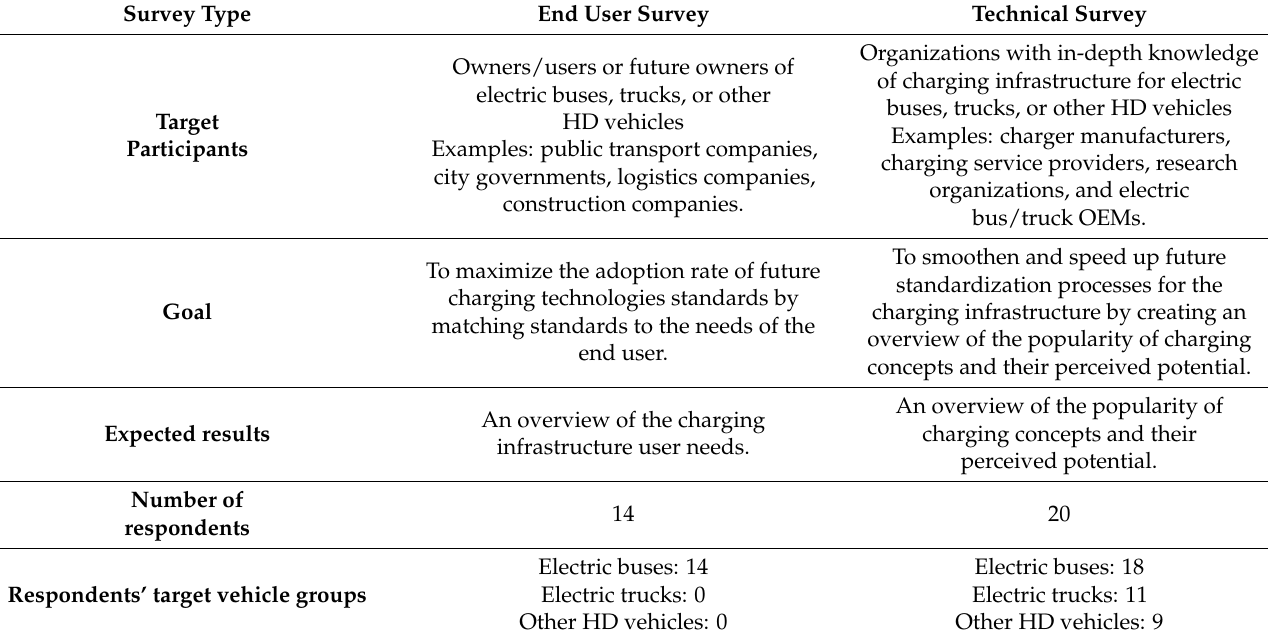
Table 4. Contents summary of surveys for the foreseen developments in the